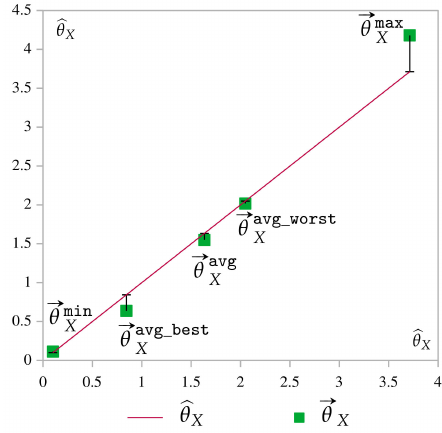
Figure 8. Estimates based on table